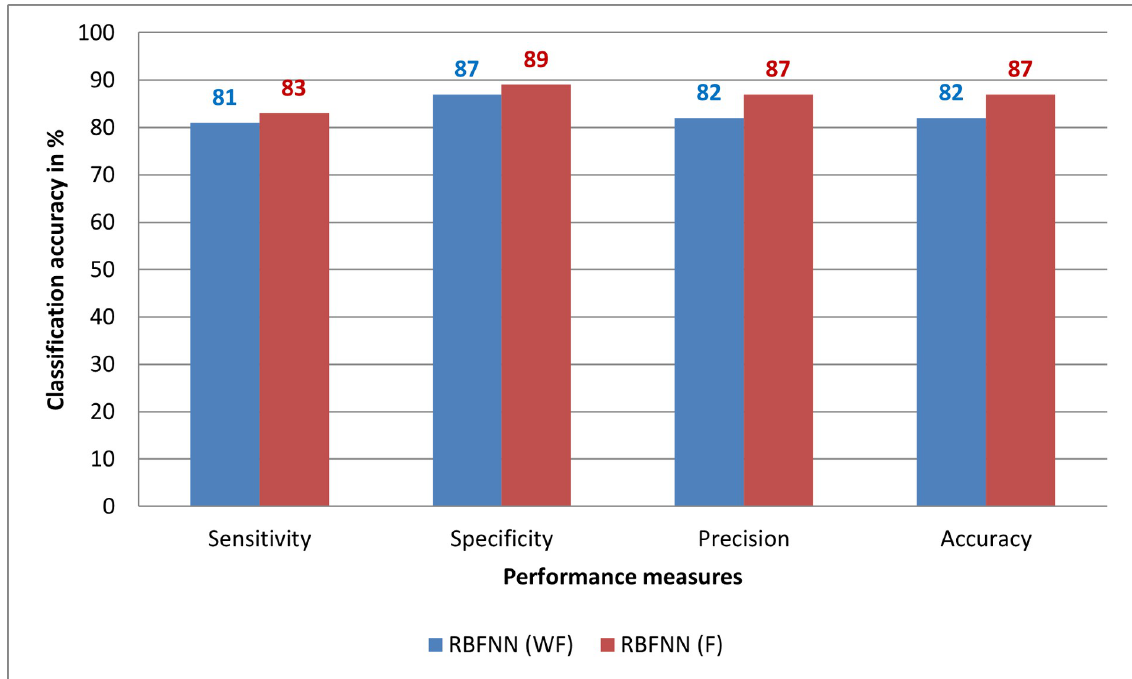
Fig 10. Performance analysis of RBFNN classifier in leaf disease detection.